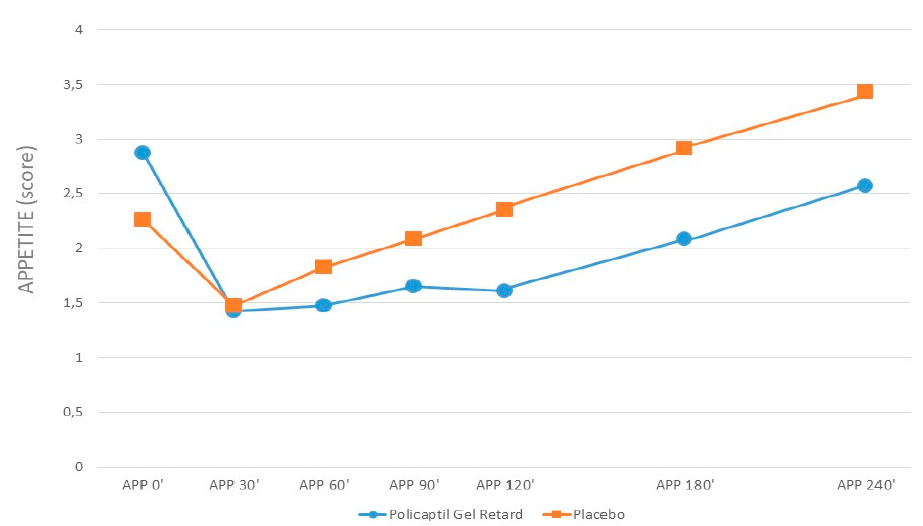
Figure 3. Appetite visual analog scale scores before and after the ingestion of PGR or placebo.